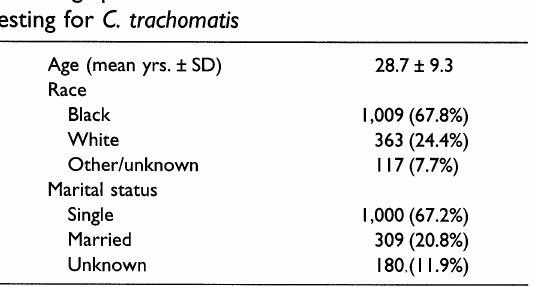
TABLE 3. Outcome of initial testing for C. trachomatis by culture and PCR in 1,588